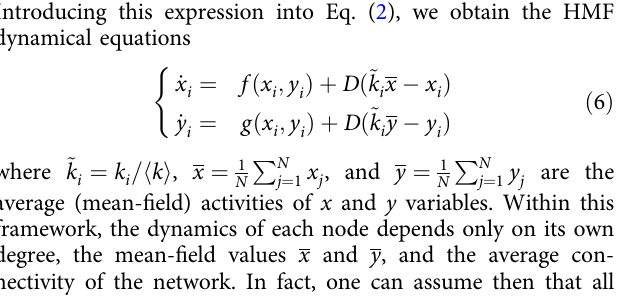
Figure 5c, d show the outcome of such simulations in WS. As we are considering two-dimensional single-node dynamics, blue and green continuous lines show the two different branches of the dispersion relation whenever they are different, such as in panel b.